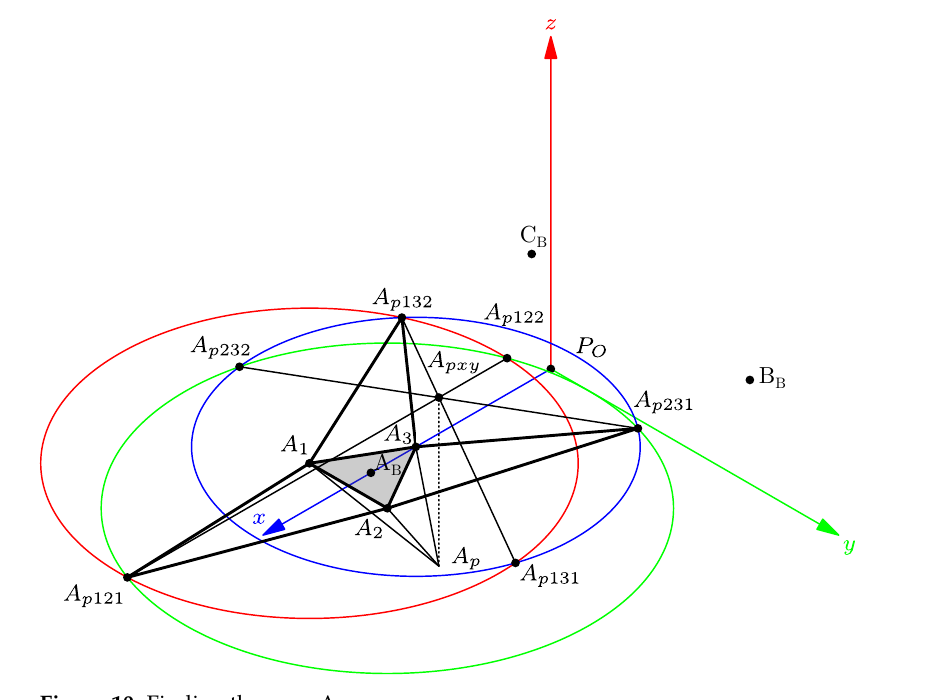
Figure 10. Finding the apex A p